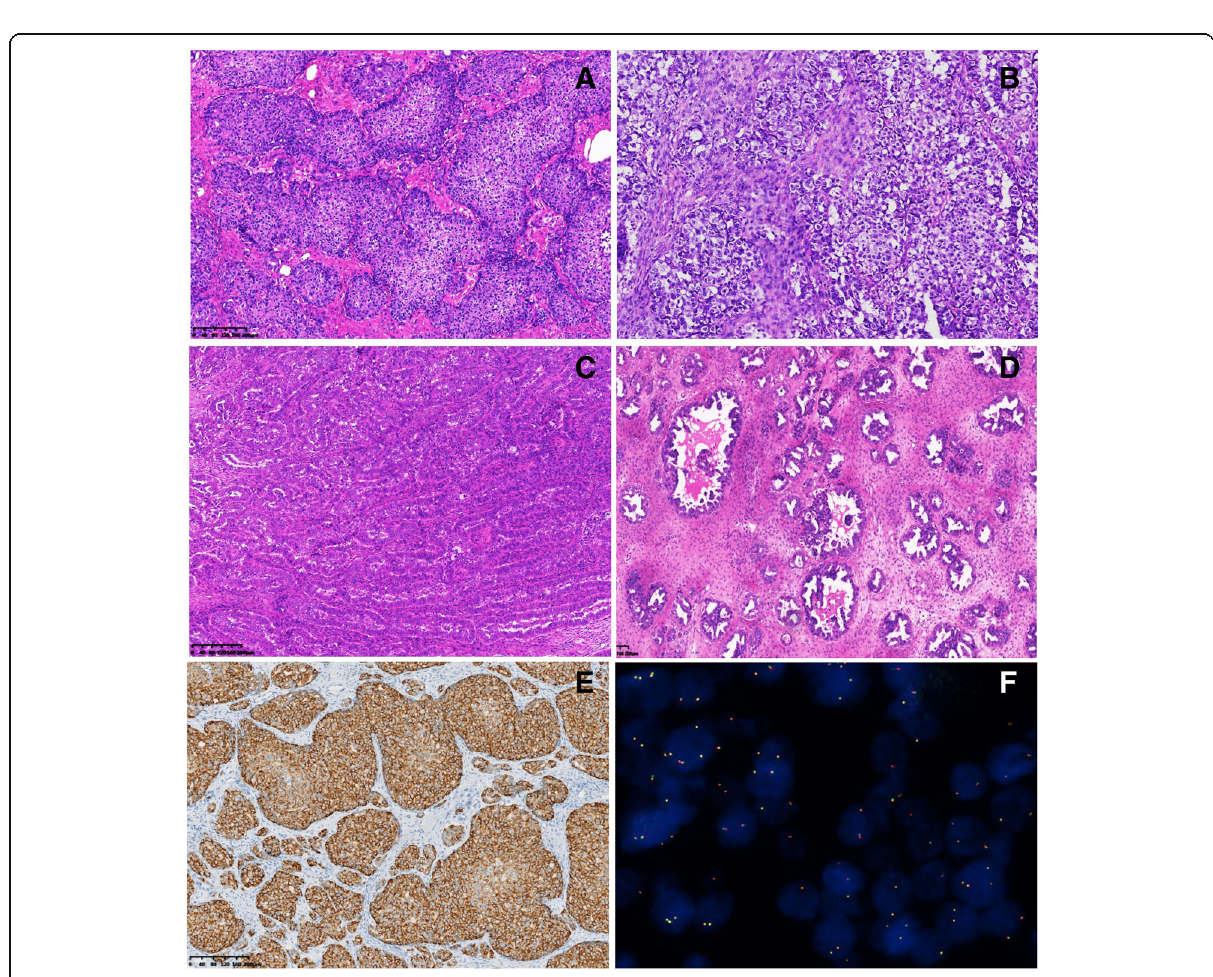
Fig. 2 Histological subtypes of ovarian metastatic lung adenocarcinomas. a and b , LTO_1 and LTO_6, solid subtype; c and d , LTO_4 and LTO_5, acinar subtype; e . ALK (D5F3) diffuse expression in LTO_1; f . ALK rearrangement with split orange and green signals by